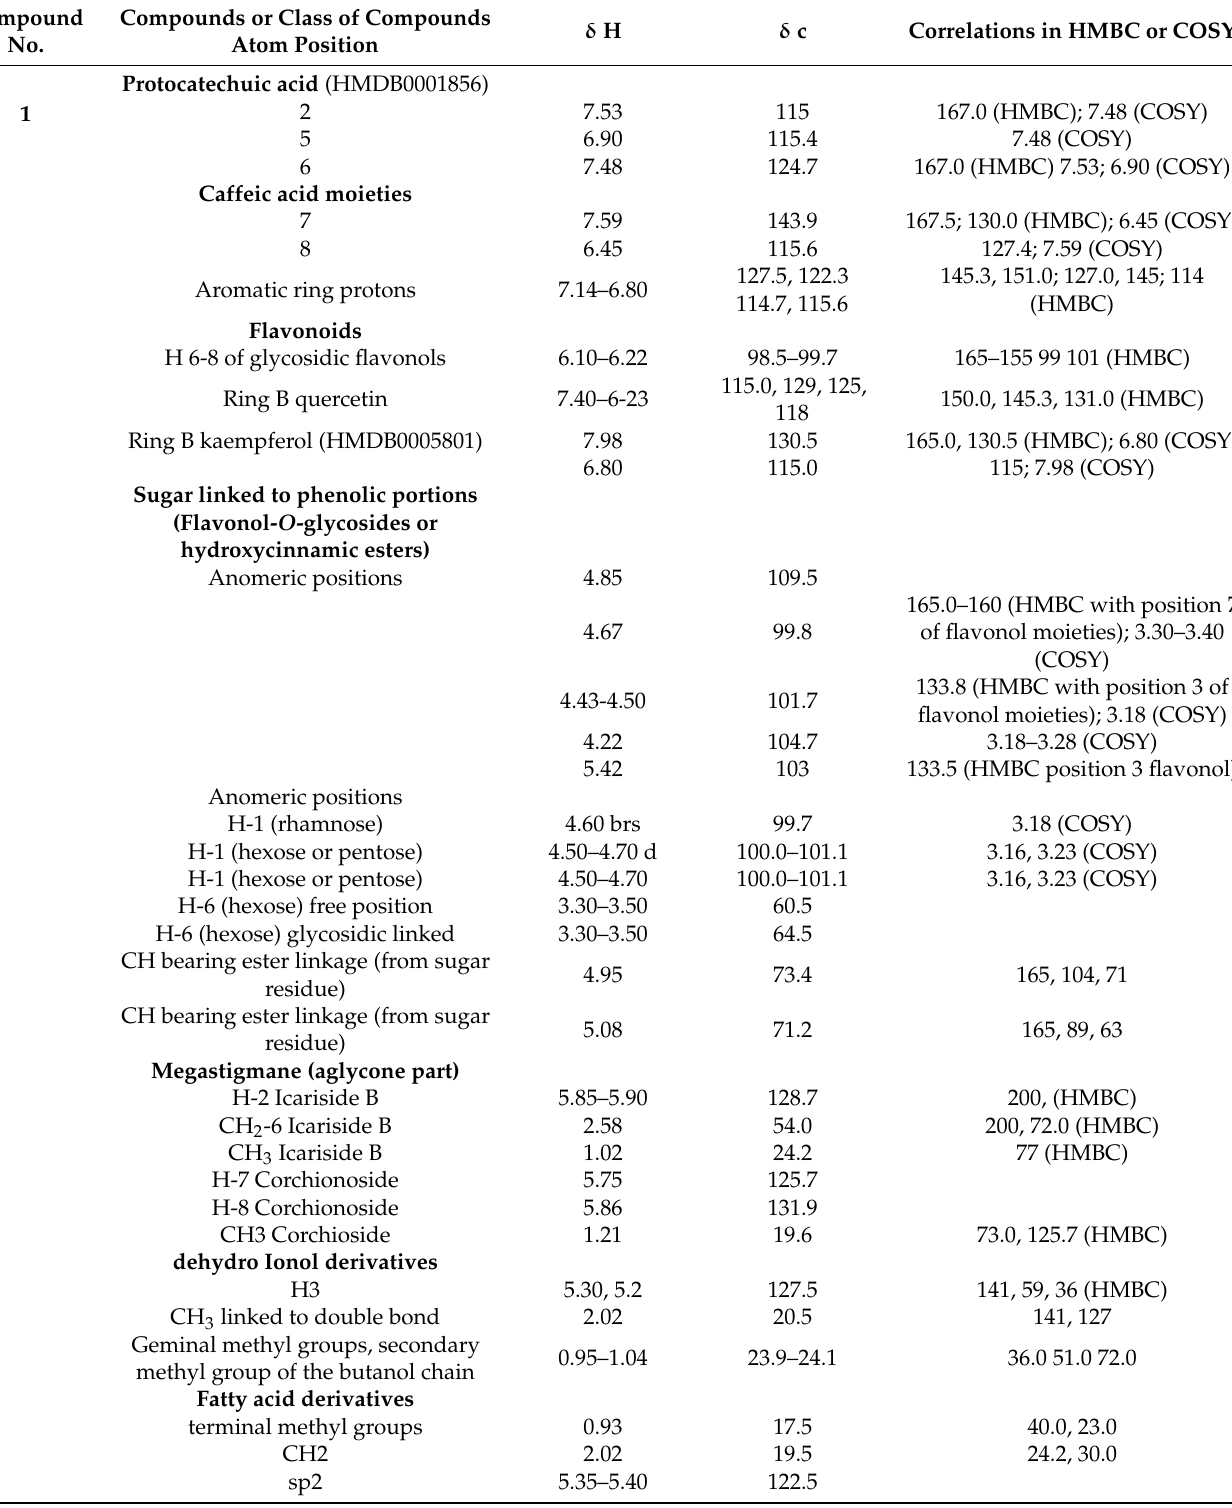
Table 1. NMR data obtained from 1D and 2D NMR experiments and assignments of constituents identified in Croton hirtus extract. COSY, correlation